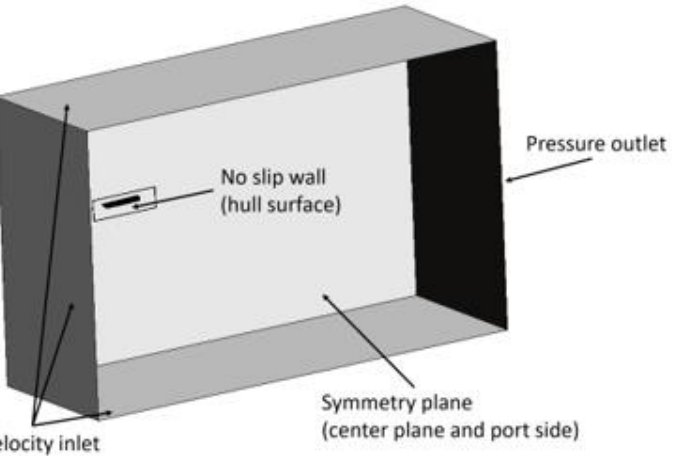
Figure 8. Boundary conditions used in simulations. The front, top, and bottom of the domain are set to velocity inlets. The rear of the domain enforces hydrostatic pressure at the outlet. The sides of the domain are modeled as symmetry planes and the hull surface is treated as a no slip wall.